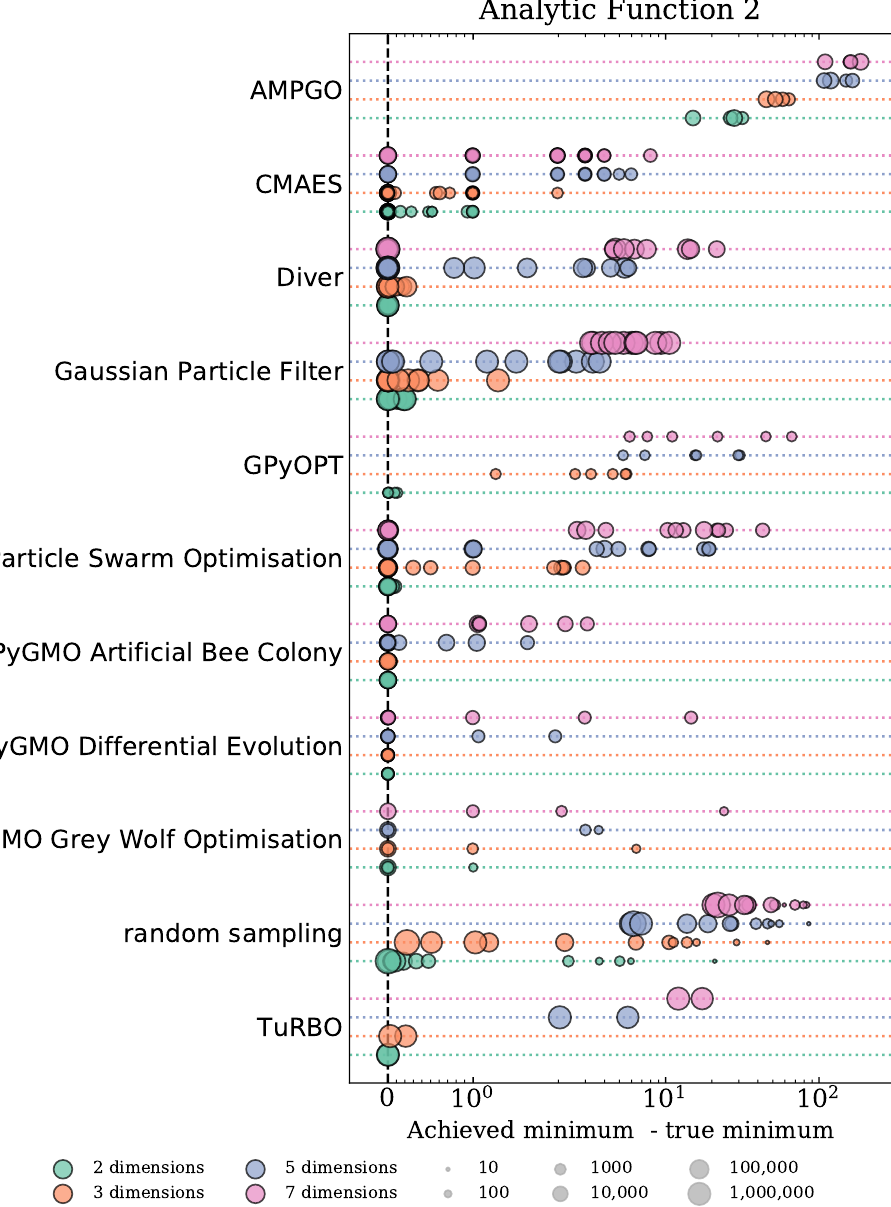
Figure 5. Results from different optimisation algorithms on the analytic function in equation (3.2). The results are shown as semi-opaque circles, of which the area increases logarithmically with the number of function evaluations needed to obtain that specific result. The four horizontal lines for each algorithm belong to the four explored dimensionalities, from top to bottom 7-dimensional (pink), 5-dimensional (purple), 3-dimensional (orange) and 2-dimensional (green). The horizontal axis shows the difference between the (known) log-likelihood at the global minimum and that at the found